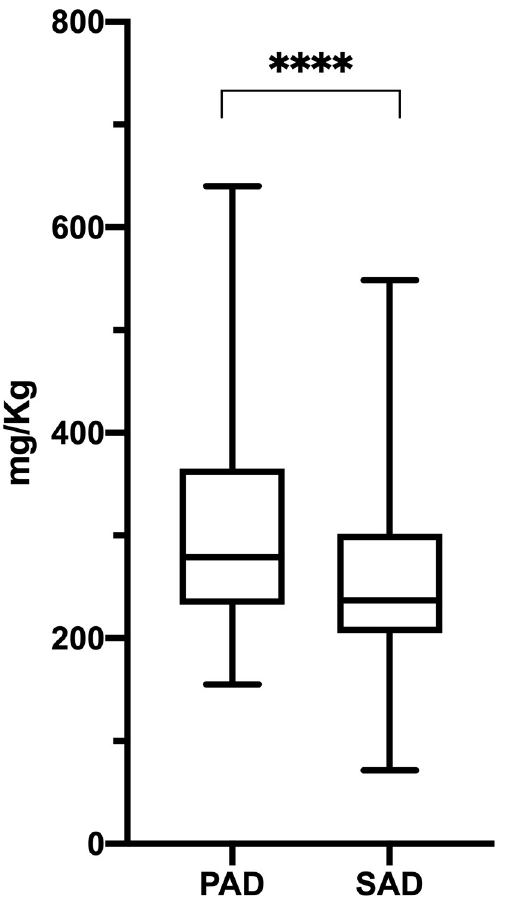
Fig 2. Steady state SCIG dosage in PAD and SAD patients. At the steady state, PAD patients received SCIG at statistic significant higher dose as compared to SAD patients (PAD: 309.31 ± 95.33 mg/kg, range 154.94–640.00 mg/kg; SAD: 251.94 ± 82.20 mg/kg, range 71.42–548.57 mg/kg; p < .0001). Levels of significance for comparison by Mann Whitney test: ns, not significant, � p � .05, �� p � .01, ��� p � .001, ���� p � .0001.